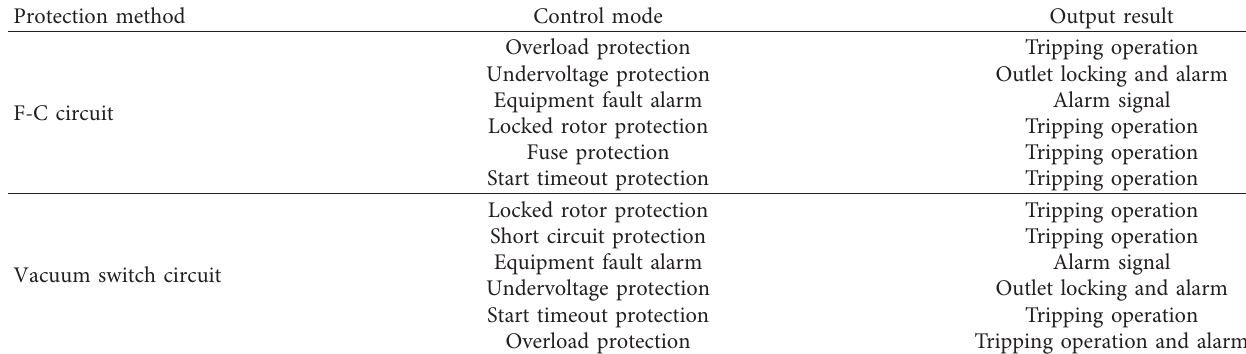
Table 2: Motor protection control mode.